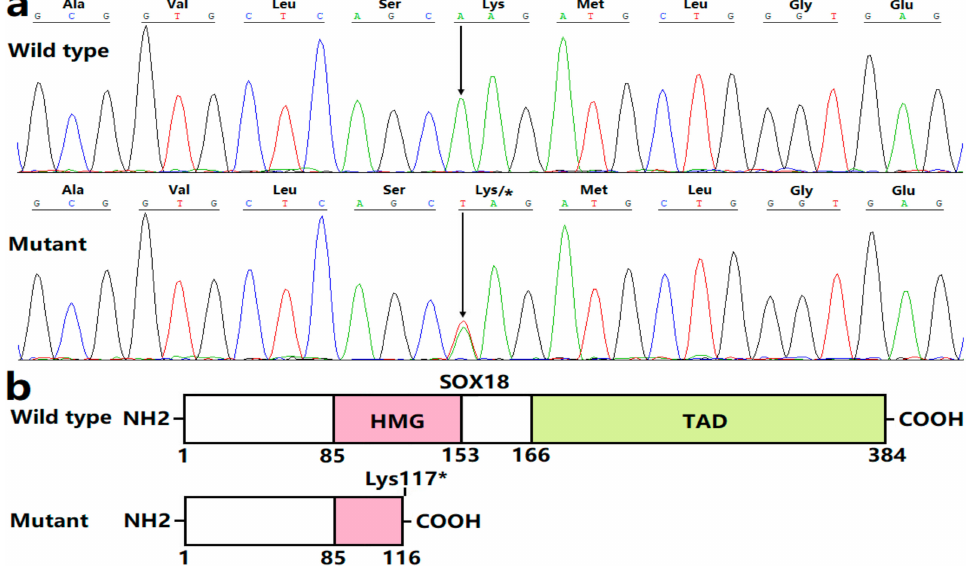
Figure 3. A novel SOX18 variation accountable for congenital cardiovascular anomalies. ( a ) Sequence chromatograms displaying the heterogeneous SOX18 variation in the affected proband (mutant) in contrast to a homozygous wild type in a healthy individual (wild type). An arrow directs where the variation occurs. ( b ) Schemas describing the pivotal structural domains of SOX18.